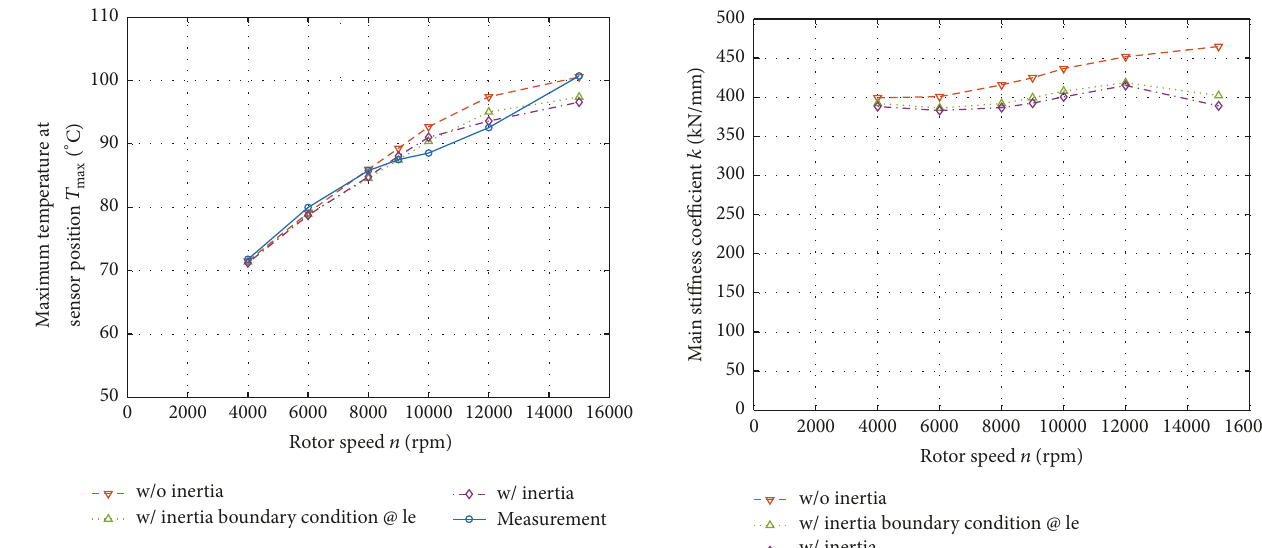
Figure 16: Comparison of measured and predicted maximum sensor temperatures for different simulation boundary conditions (TPB120, 𝑝 𝑞 = 2.0 MPa, 𝑄 = 90 l/min, 𝑇 sup = 50 ∘ C, and 𝑧 = 36 mm).